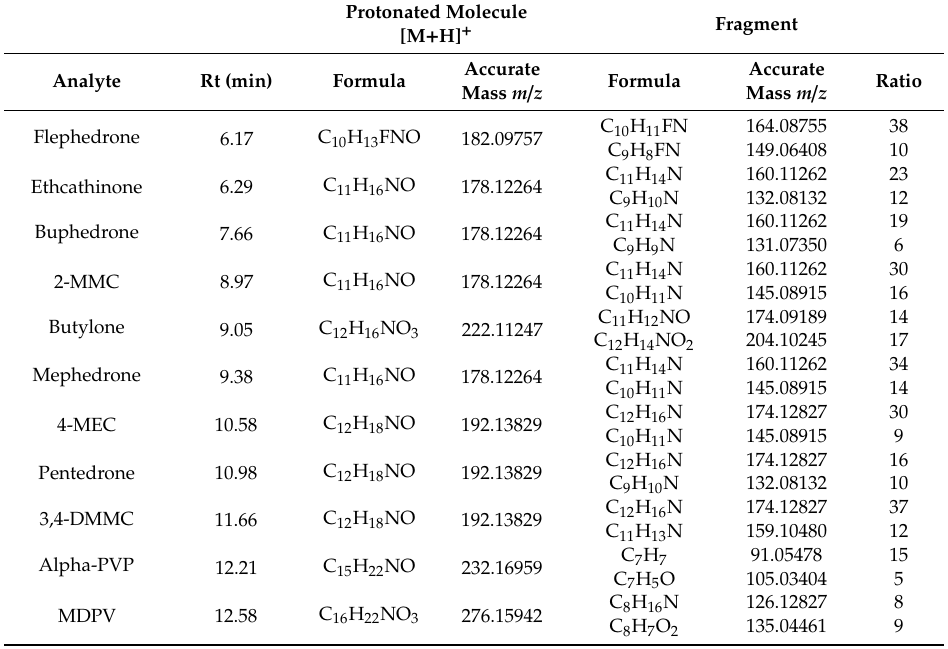
Table 1 specifies the LC-HRMS protonated molecules and fragments. The ion ratio was calculated by dividing the signal of the protonated molecule by the one of the fragment. Table 1. Retention time, protonated molecule (quantifier), the two fragment ions (qualifier), and the ratios of the studied cathinones by liquid chromatography high-resolution mass spectrometry